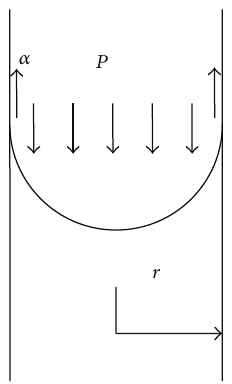
Figure 10: Stress analysis of the